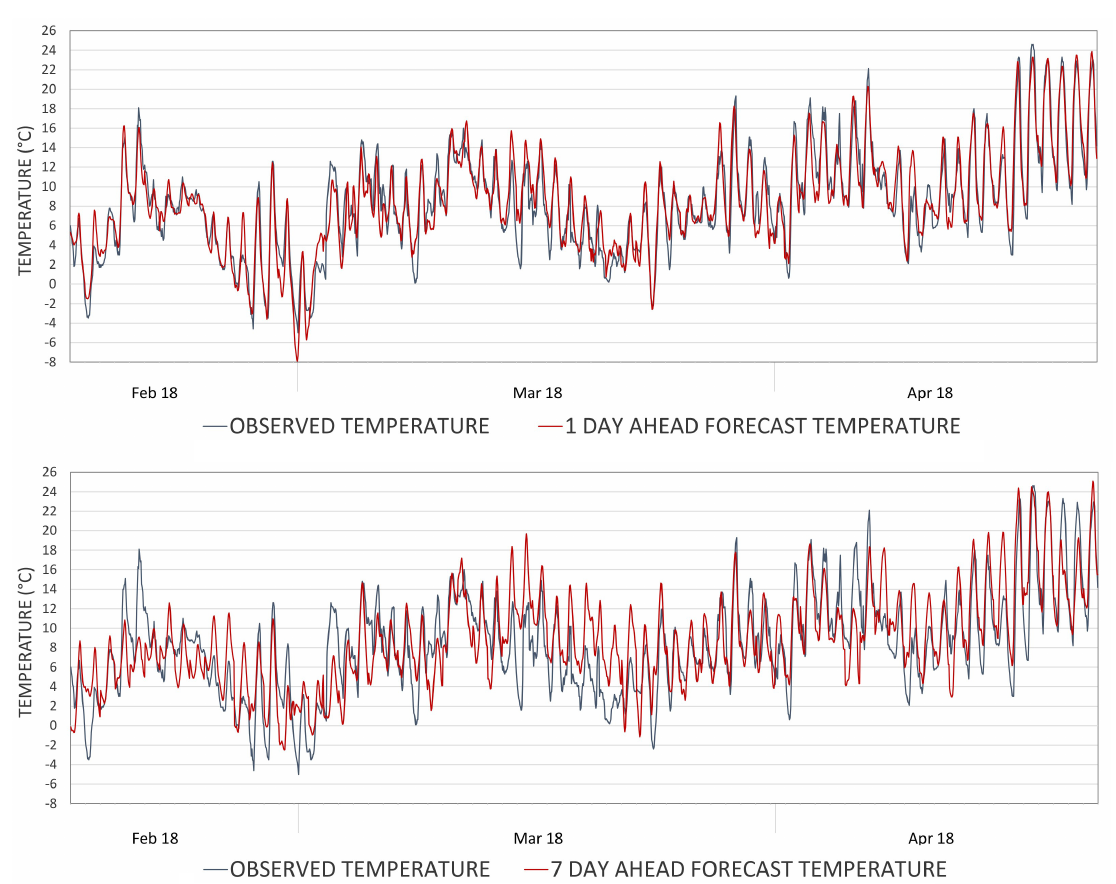
Figure 5. Comparison between observed and forecast outdoor temperature at Pamplona (12 February 2018–22 April 2018). Above: 1-day forecast outdoor temperature. Below: 7-day forecast outdoor